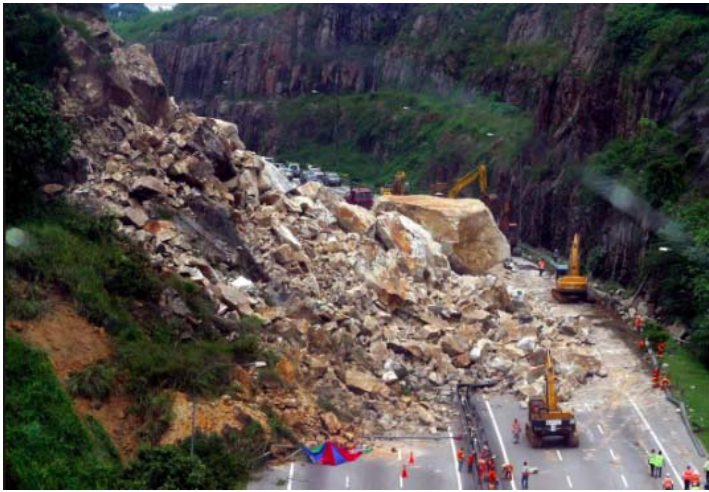
Figure 15. The Bukit Lanjan rockfall along the New Klang Valley Expressway in November 2003 resulted in a six ‐ month closure of that particular stretch (Courtesy: Malaysia Department of Public Works).